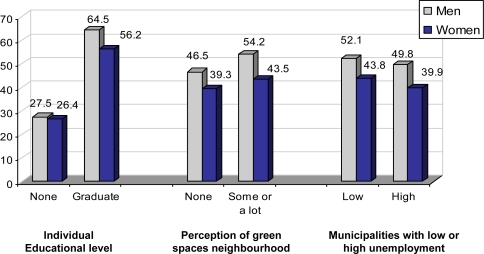
Age-adjusted Prevalence of Physical Activity in relation to individual, physical and social environment.